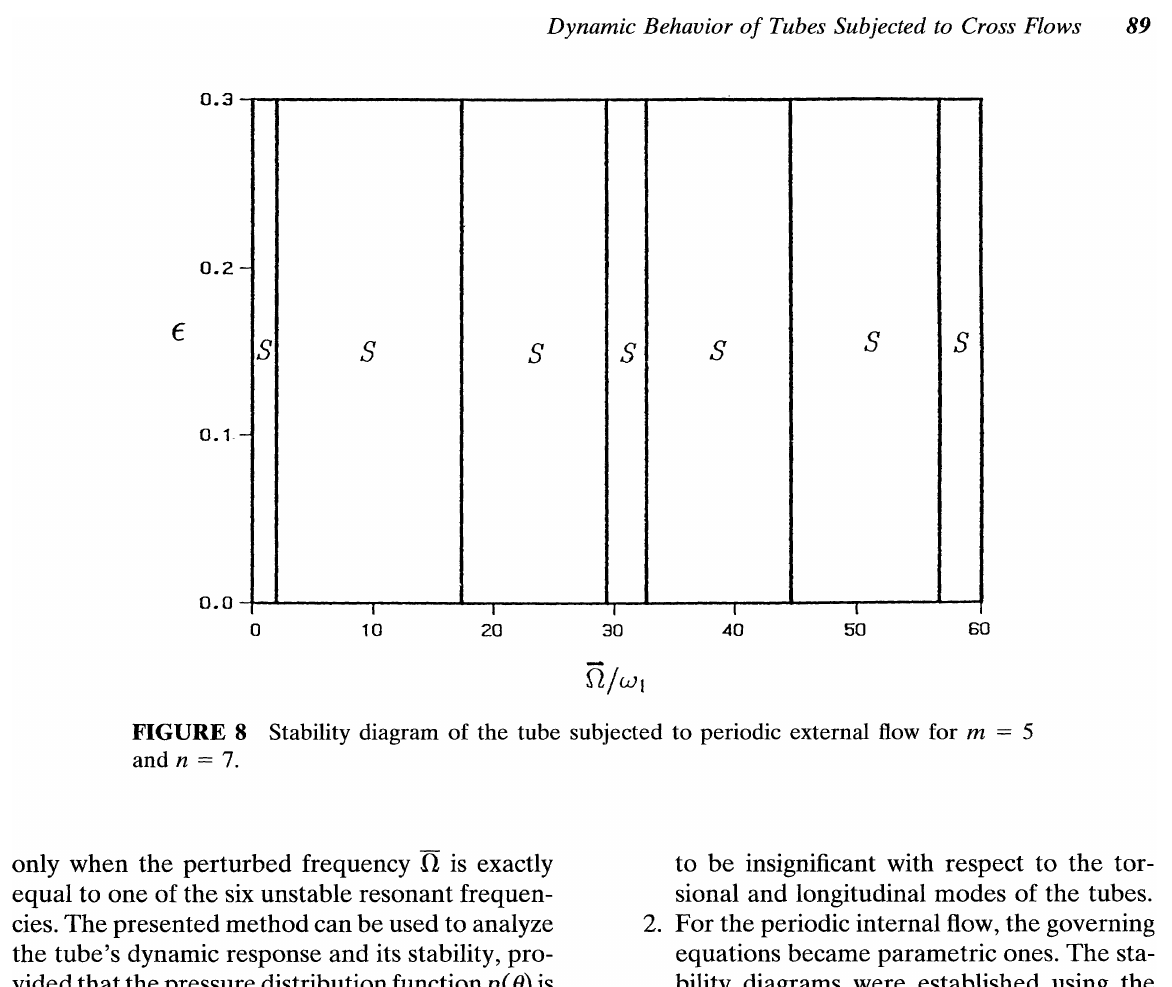
FIGURE 8 Stability diagram of the tube subjected to periodic external flow for m = 5 and n =